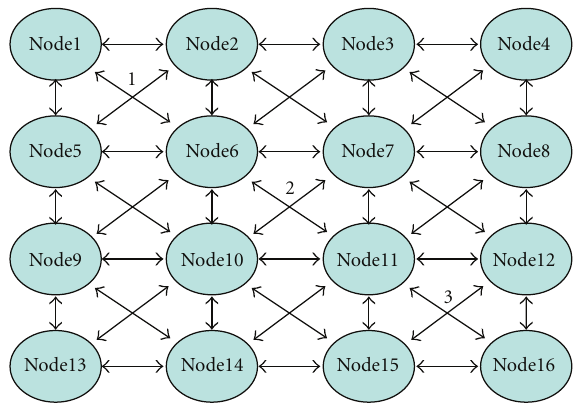
Figure 10: TDMA Schematic Diagrams of 16-node Scenario.